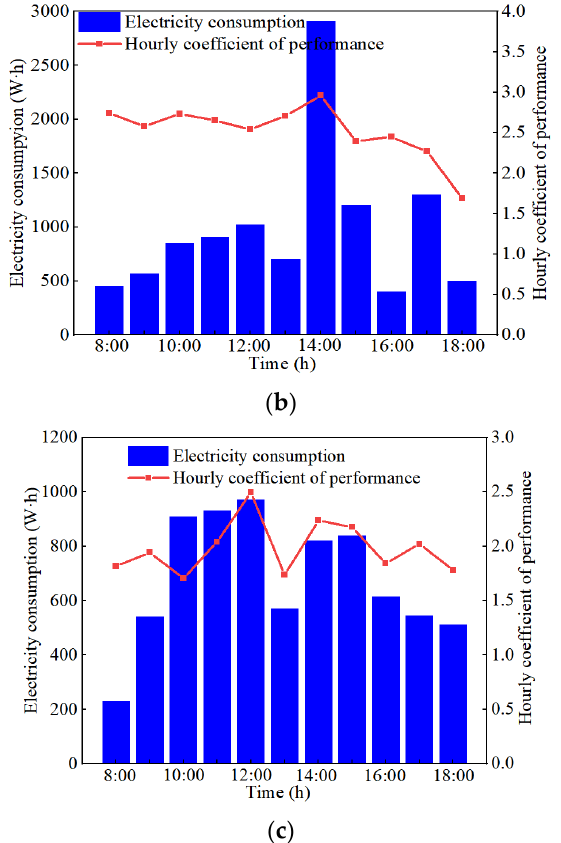
Figure 15. Energy consumption under the ( a ) LH, ( b ) HL, and ( c ) MM operating strategies.